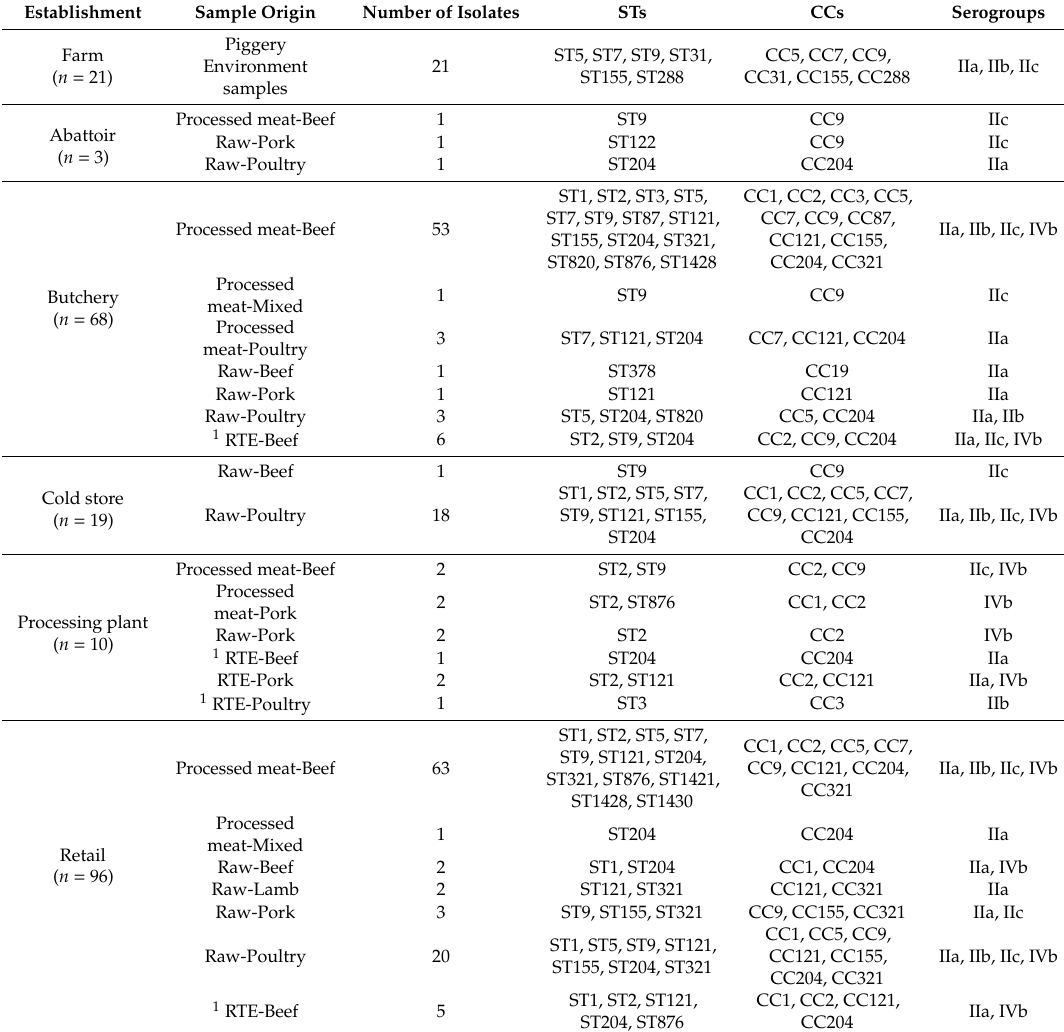
Table 1. Number of isolates for each category together with the di ff erent STs and serogroups found in each